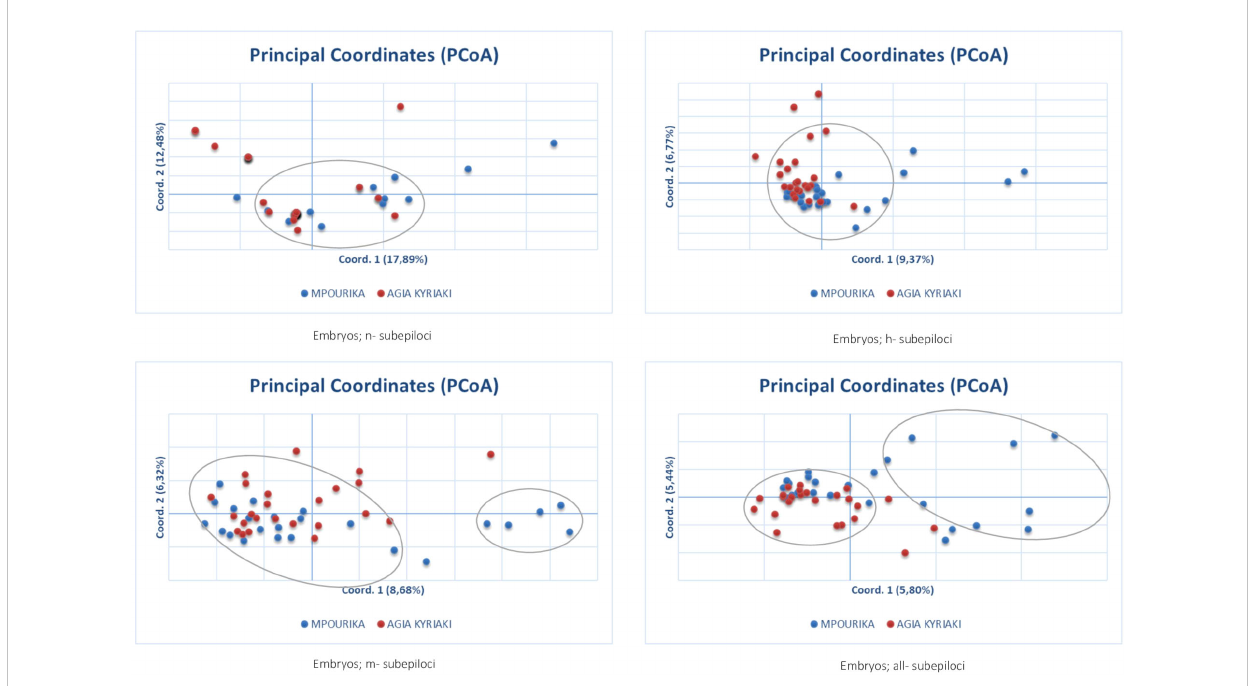
FIGURE 5 Principal coordinate analysis (PcoA) of epigenetic distances based on MSAP analyses of embryo tissue, in the exposed (Mpourika) and the control (Ag. Kyriaki)